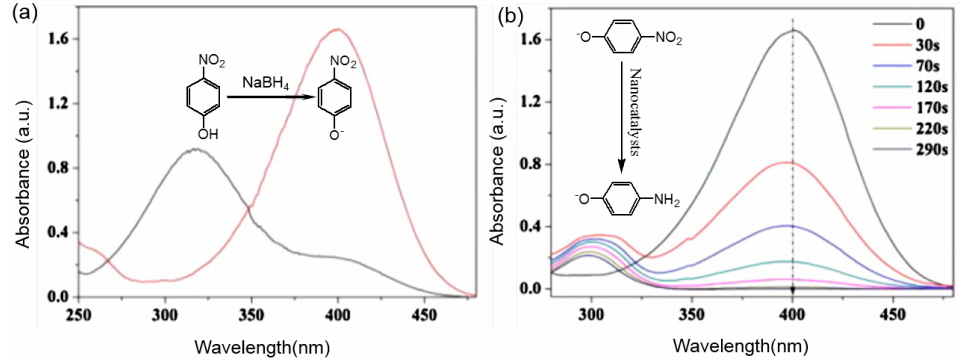
Figure 4. ( a ) UV-VIS spectra of 4-nitrophenol before and after adding NaBH 4 solution; ( b ) the reduction of 4-nitrophenol over the magneticaaly recyclable Ni@Pd/KCC-1 nanocatalysts. Reprinted with permission from